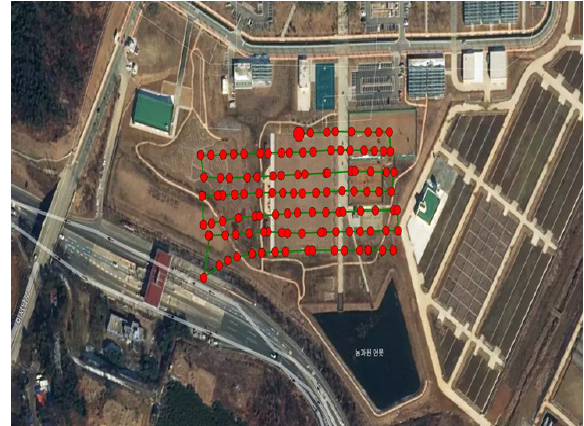
Figure 1. Flight trajectory of the UAV (green line) and the locations of the images acquired (red dots)